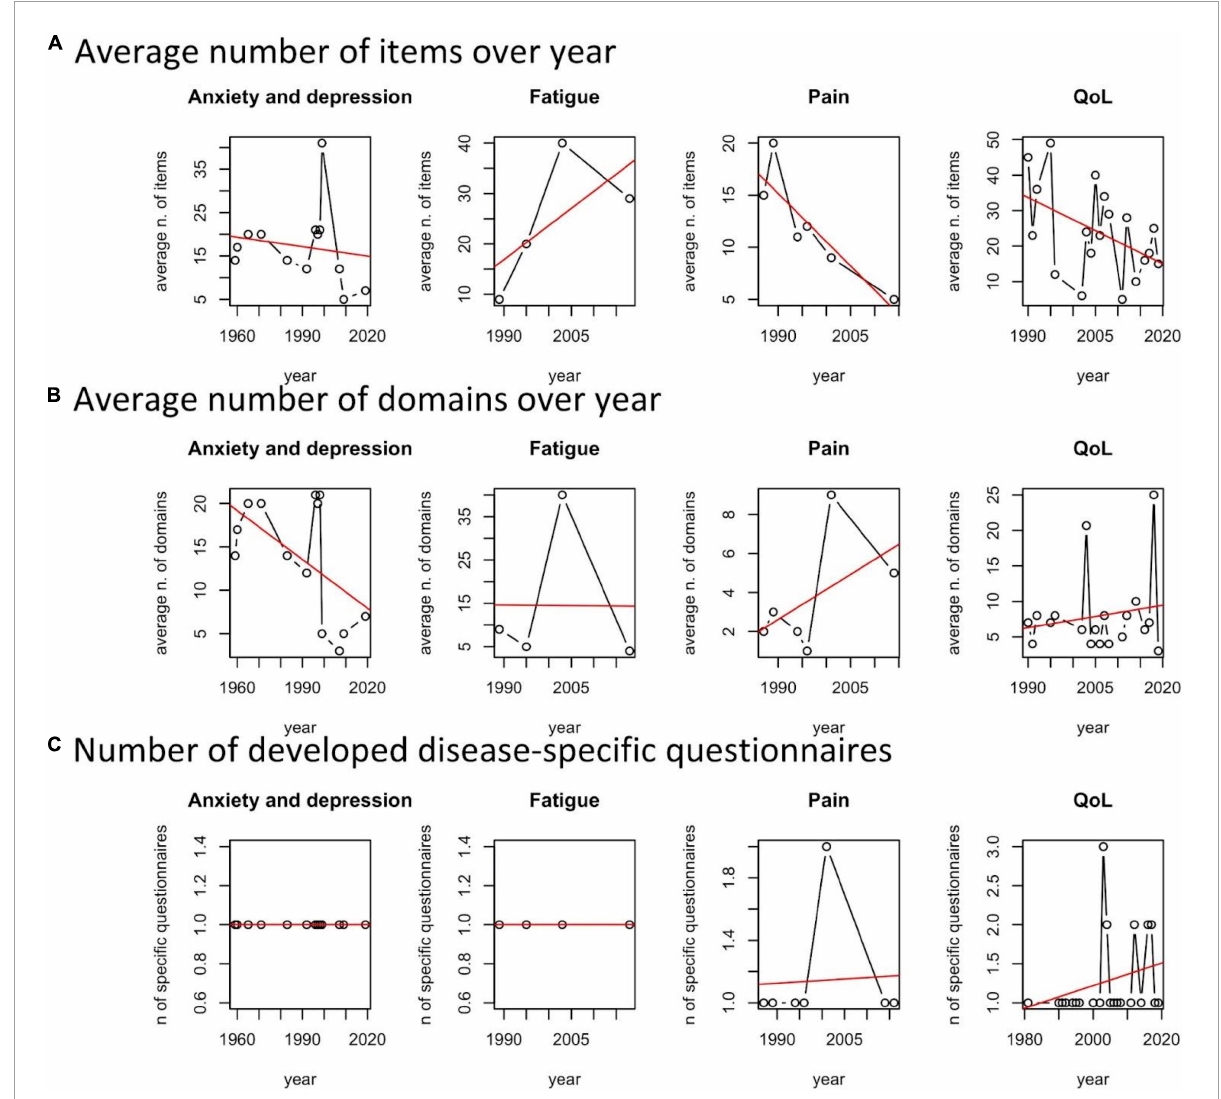
FIGURE5 Average number of issues, domains, and number of developed disease-specific questionnaires per year and patient reported outcome measures (PROMs) area.